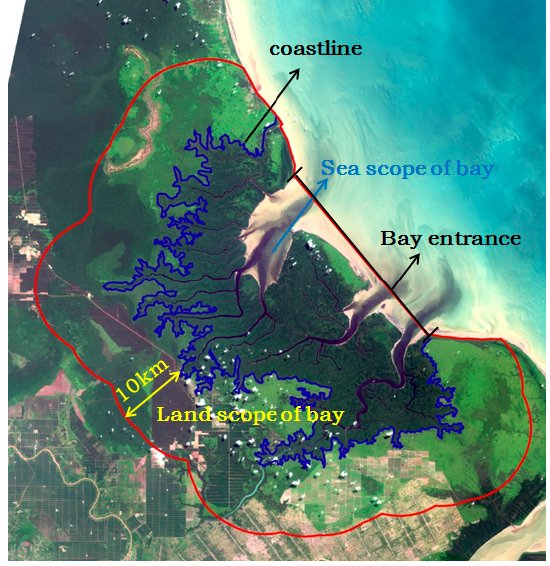
Figure 2. Scope of bay.